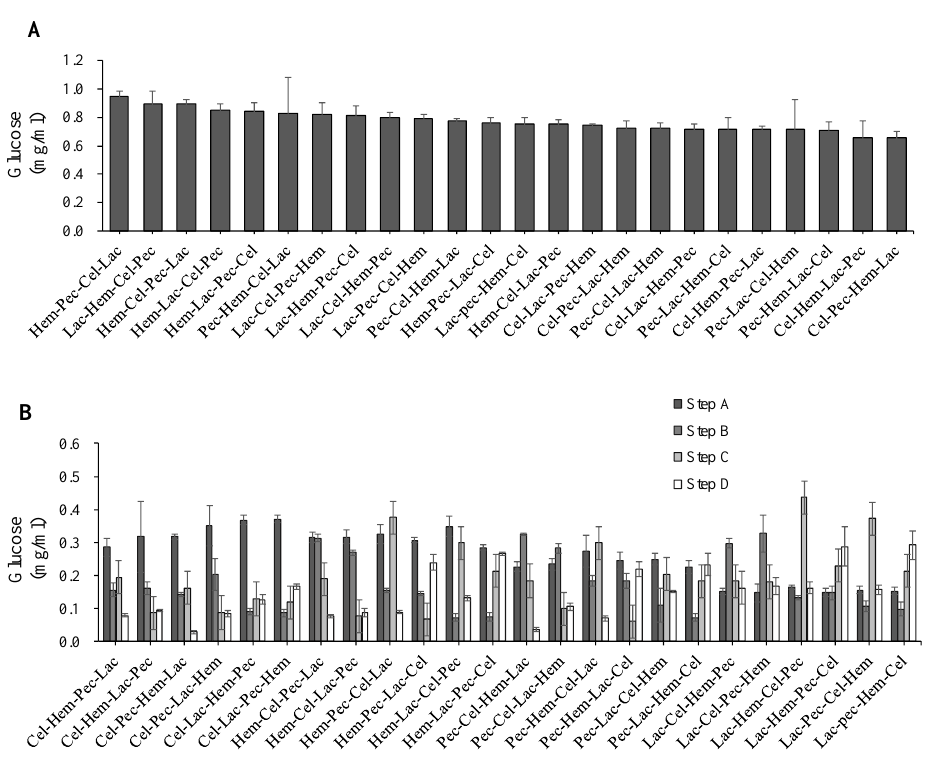
Figure 4. The effect of enzyme sequence action on the release of glucose. ( A ) Total glucose production during four steps enzyme digestion for the corn stover (from the highest to the lowest). ( B ) Glucose production levels during four steps enzyme digestion. The error bars represent standard error of the mean ( n = 3).